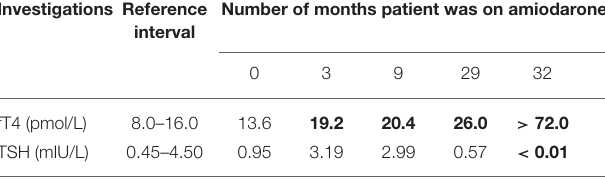
TABLE 1 | TFT Trend while patient was on